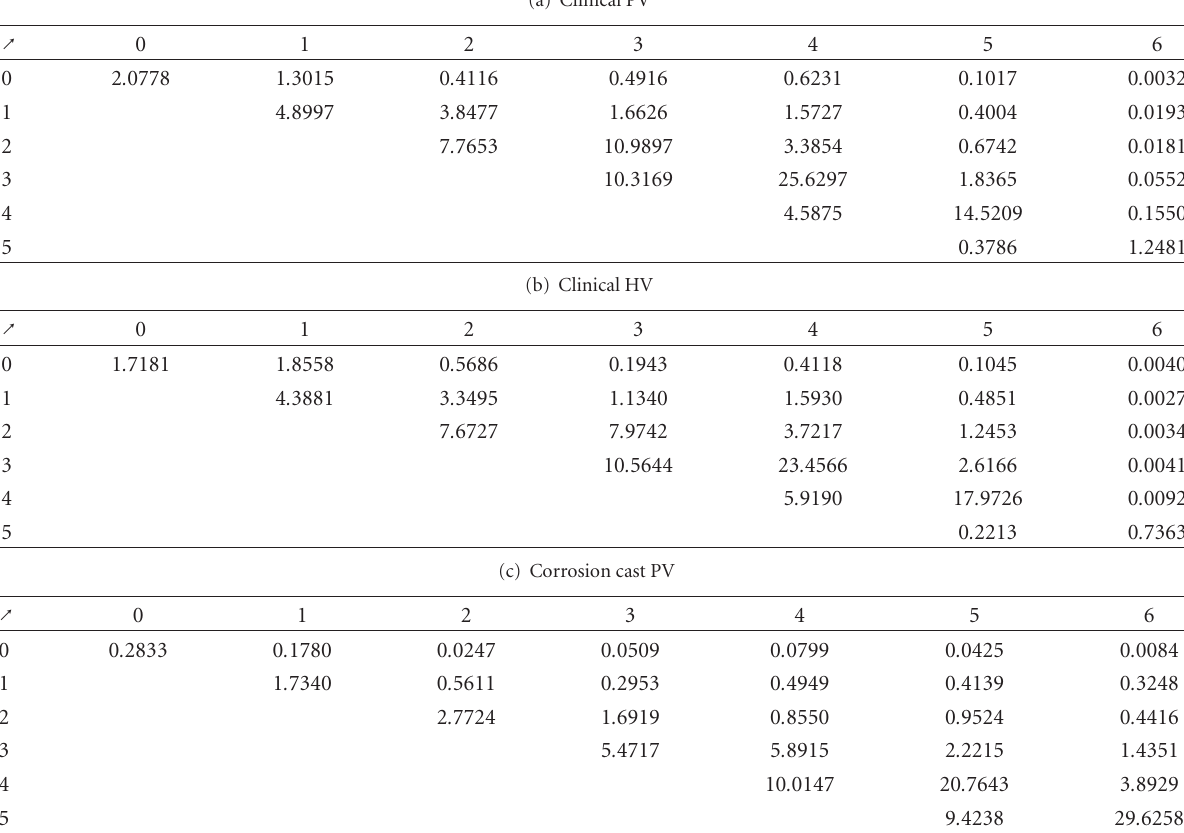
Table 2: Histogram (in percent) of transitions at bifurcations between di ff erent Strahler ∗ orders present in the human clinical PV and HV ((a) and (b)) and corrosion cast PV (c)